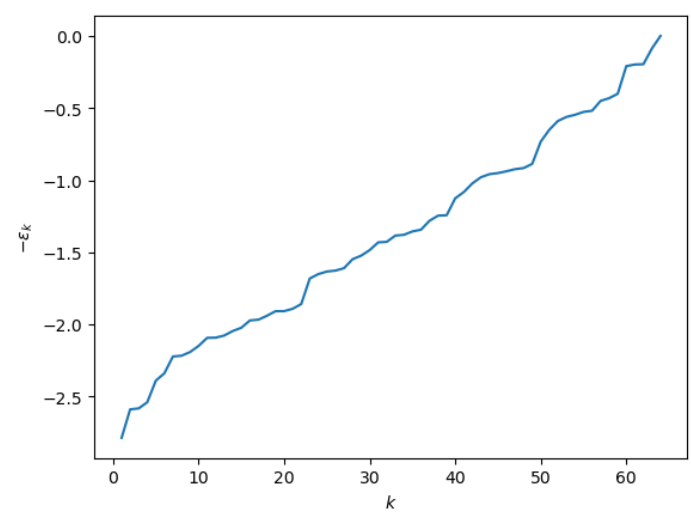
Figure 3: Output of examples 3.11. In the plot are represented the eigen- values of a random nearest-neighbour Hamiltonian computed with the code Random_NNHamiltonian(N) for a system with N = 64 sites. Computing the energies of H